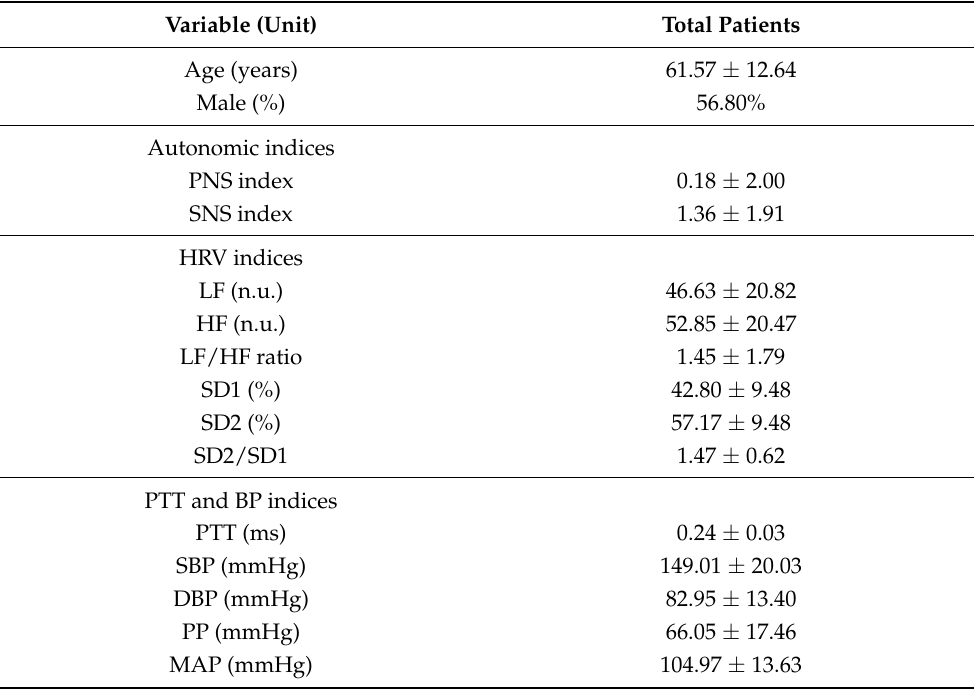
Table 1. Means and standardization of all indices, ischemic stroke patients ( n =